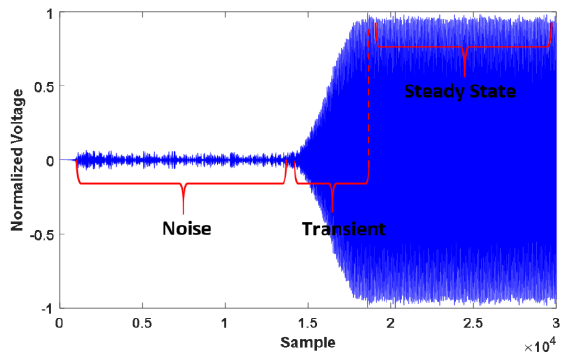
Figure 2. A sample recording from Bluetooth (BT) signals captured in laboratory.